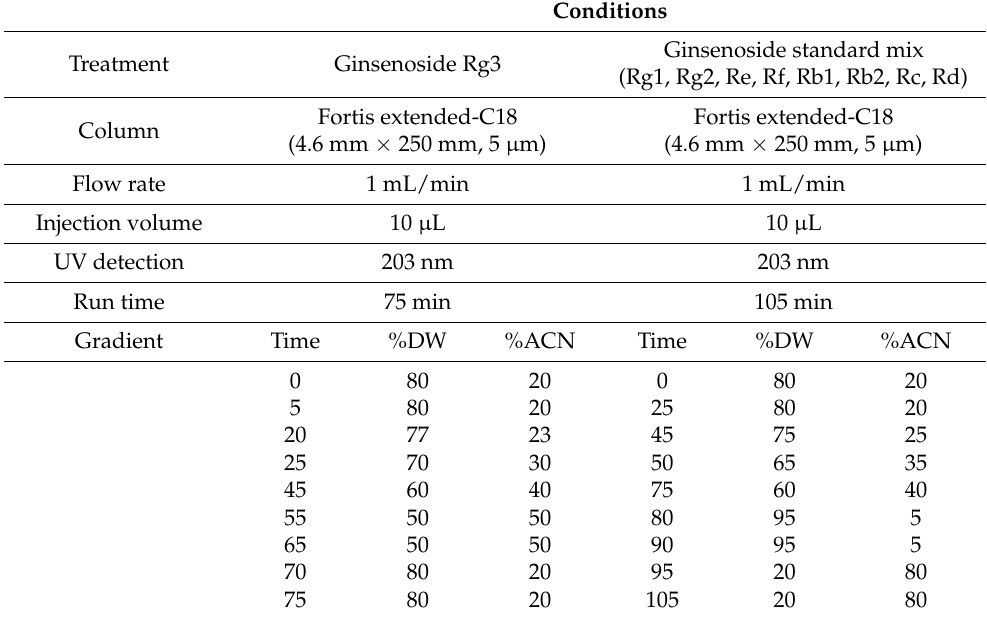
Table 1. Analytical conditions of HPLC for the ginsenosides